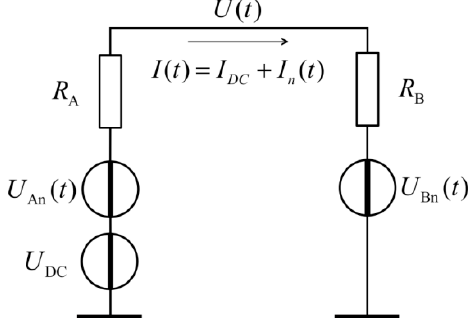
∈ { U ; U } and An LAn HAn is the ground loop DC voltage DC